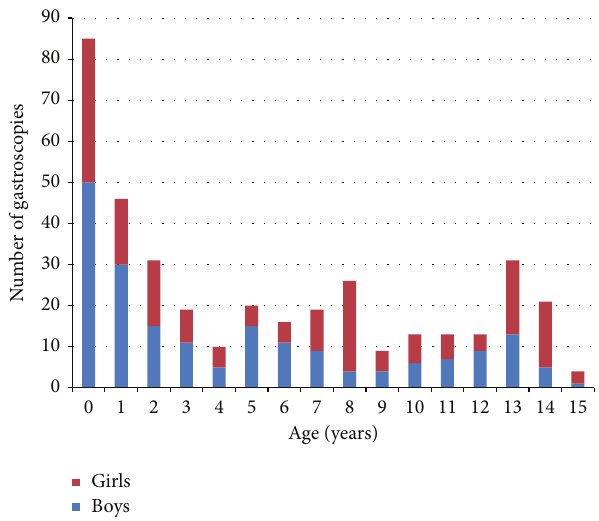
Figure 1: Age distribution across 376 gastroscopies performed from July 2011 to May 2014.